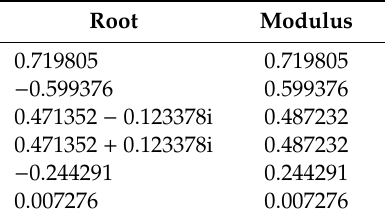
Table 9. VAR stability condition check.